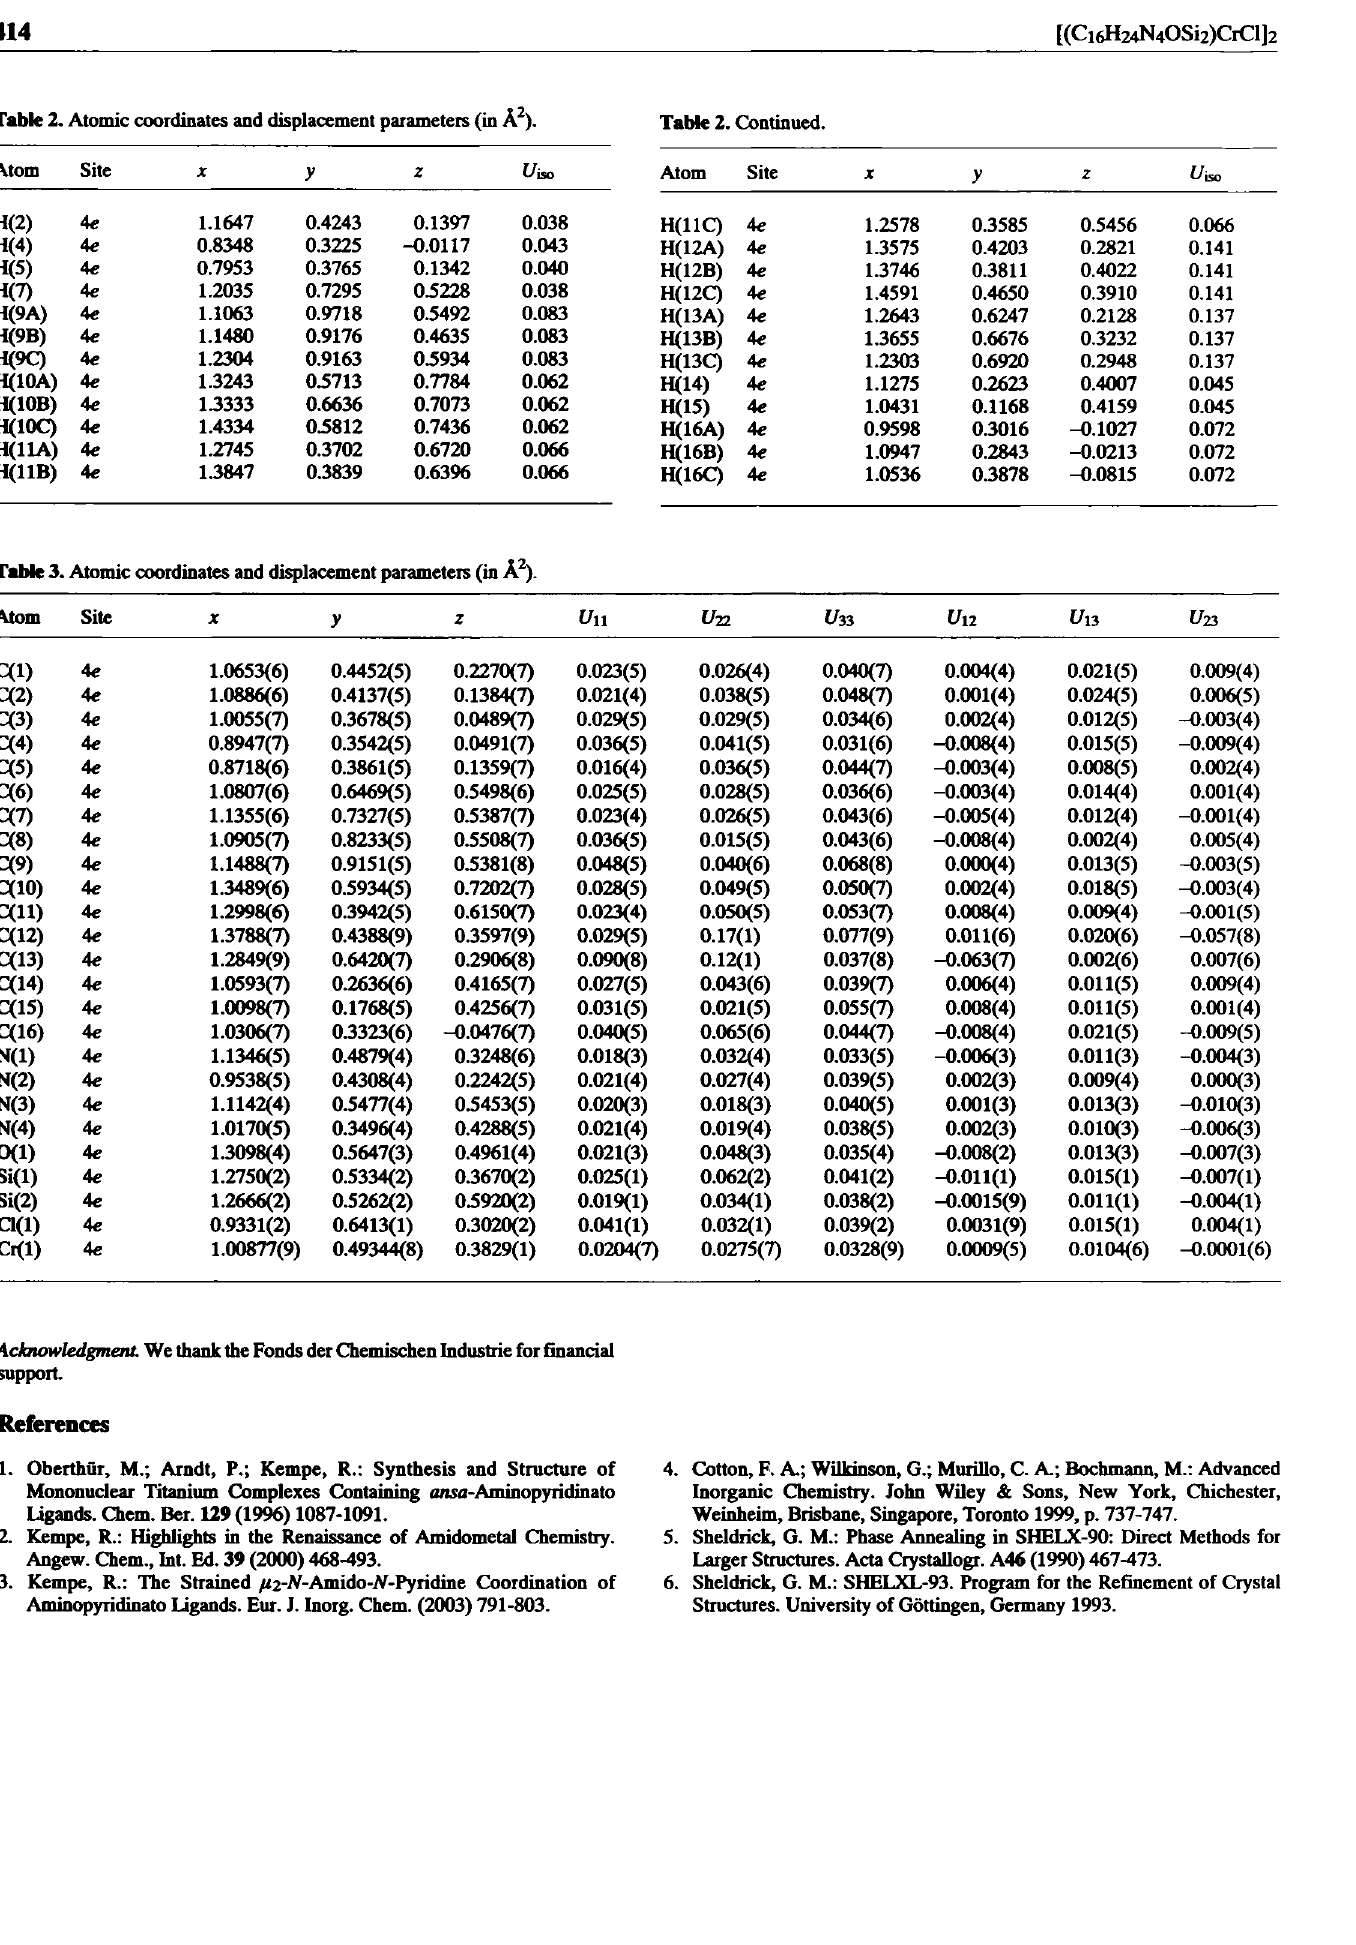
Table 2. Atomic coordinates and displacement parameters (in Ä 2 ).